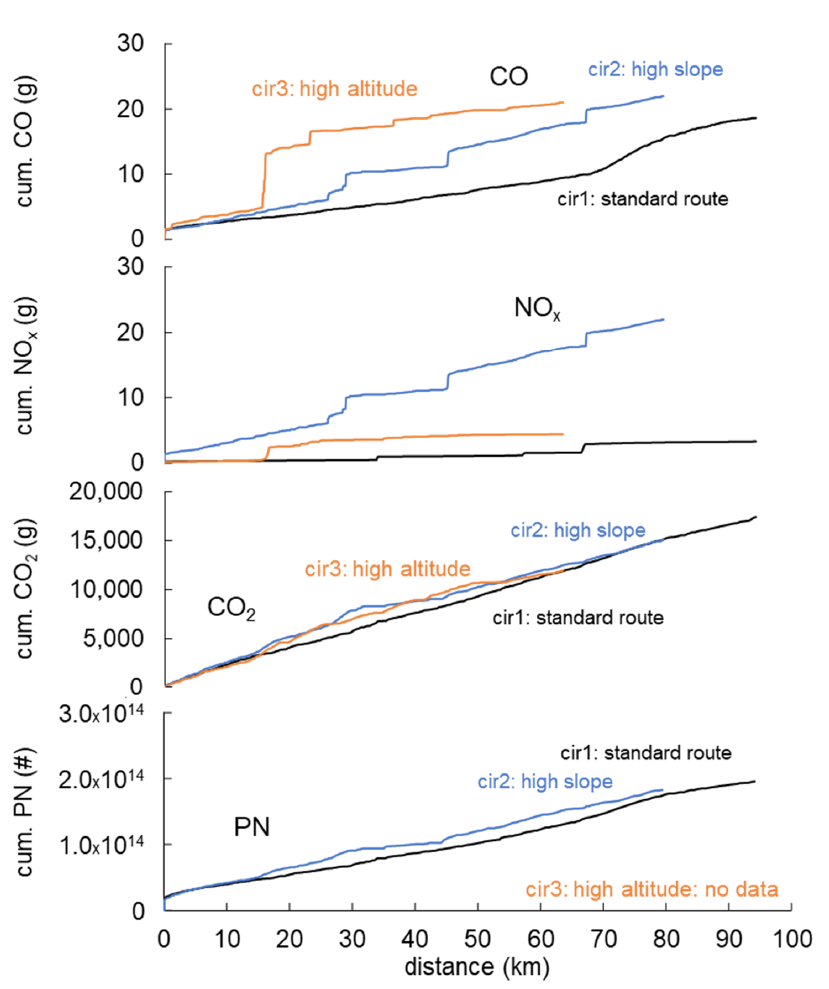
Figure 12. Influences of high altitude and altitude variations on the cumulated emissions, gasoline (V1).